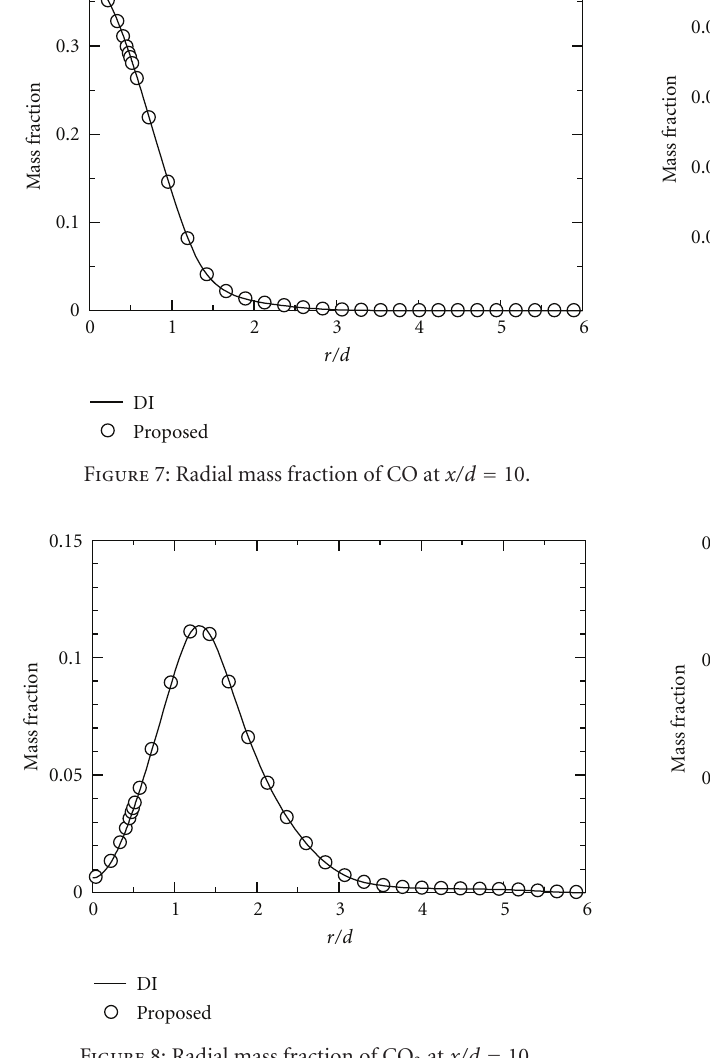
Figure 10: Radial mass fraction of CO at x/d =